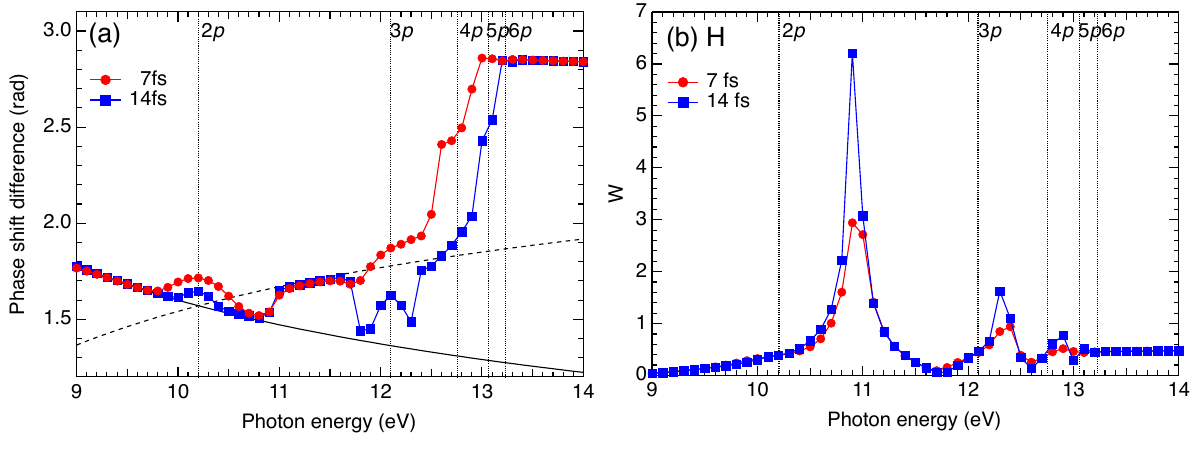
Figure 1. Photon-energy dependence of ( a ) the relative phase (phase-shift difference) δ and ( b ) the amplitude ratio W between the s and d wave packets for a pulse width of 7 fs (circles) and 14 fs (squares). The target atom is hydrogen. Thin sold and dashed lines in ( a ): | δ π − | δ | , respectively. Vertical dotted lines: positions of 2 p to 6 p sc